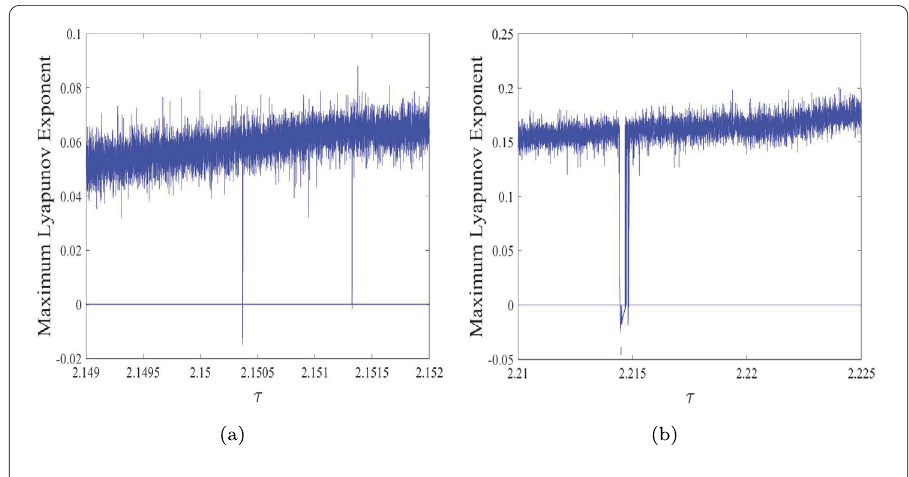
Figure 8 Local amplification of the maximum Lyapunov exponents corresponding to Fig. 7( b )